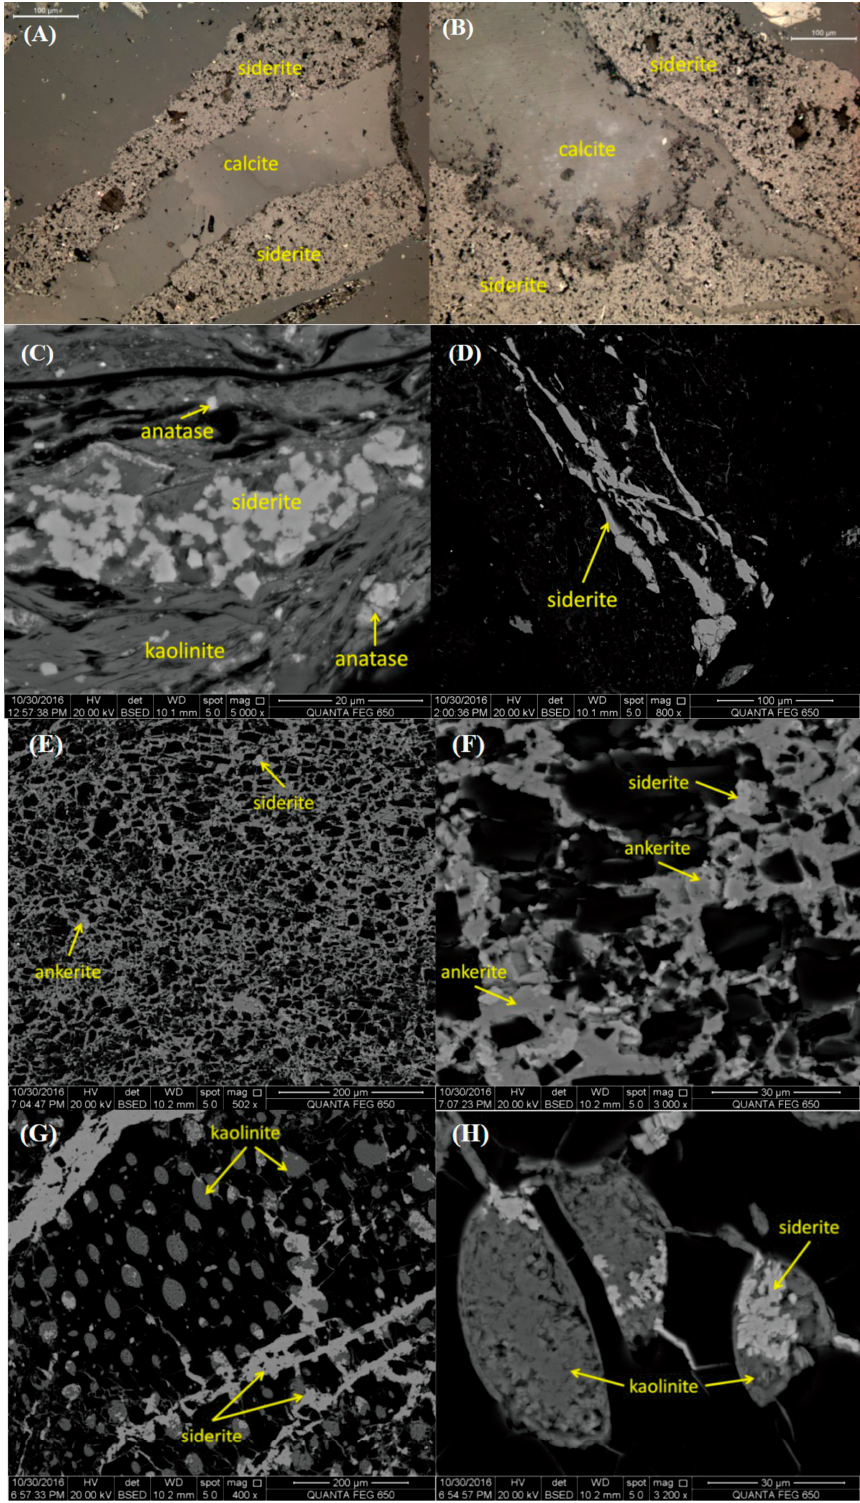
Figure 9. Carbonate minerals and kaolinite in samples investigated. ( A , B ) Massive siderite and vein like calcite, optical microscope, reflected light; ( C ) syngenetic nodules siderite in SGT1-9 sample; ( D ) rod-like siderite; ( E , F )organic matter-bound siderite and ankerite; ( G ) vein infilling siderite and cell infilling kaolinite; ( H ) Cell infilling siderite and kaolinite; ( D – H ) are SEM back-scattered images of SGT1-11 sample.